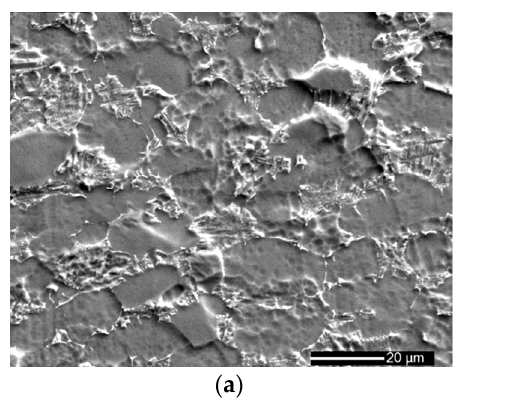
Figure 1. Microstructure of base metals: ( a ) Ti64 and ( b ) Ti17.